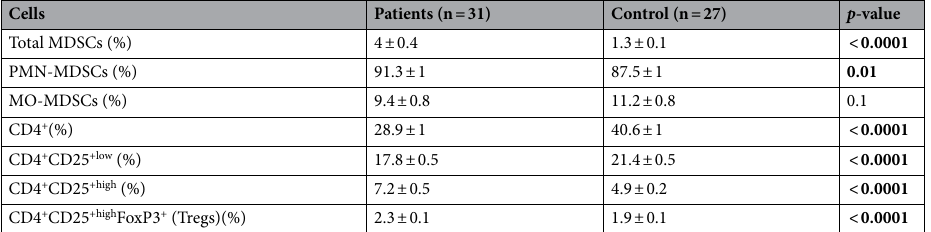
Table 2. Higher frequencies of peripheral polymorphonuclear myeloid-derived suppressor cells and regulatory T cells are detected in children with B-acute lymphoblastic leukemia. n number, MDSCs myeloid- derived suppressor cells, PMN-MDSCs Polymorphonuclear myeloid-derived suppressor cells, MO-MDSCs monocytic myeloid-derived suppressor cells, Tregs regulatory T cells. Results expressed as mean ± SE. Student’s t-test; Significant p- value <